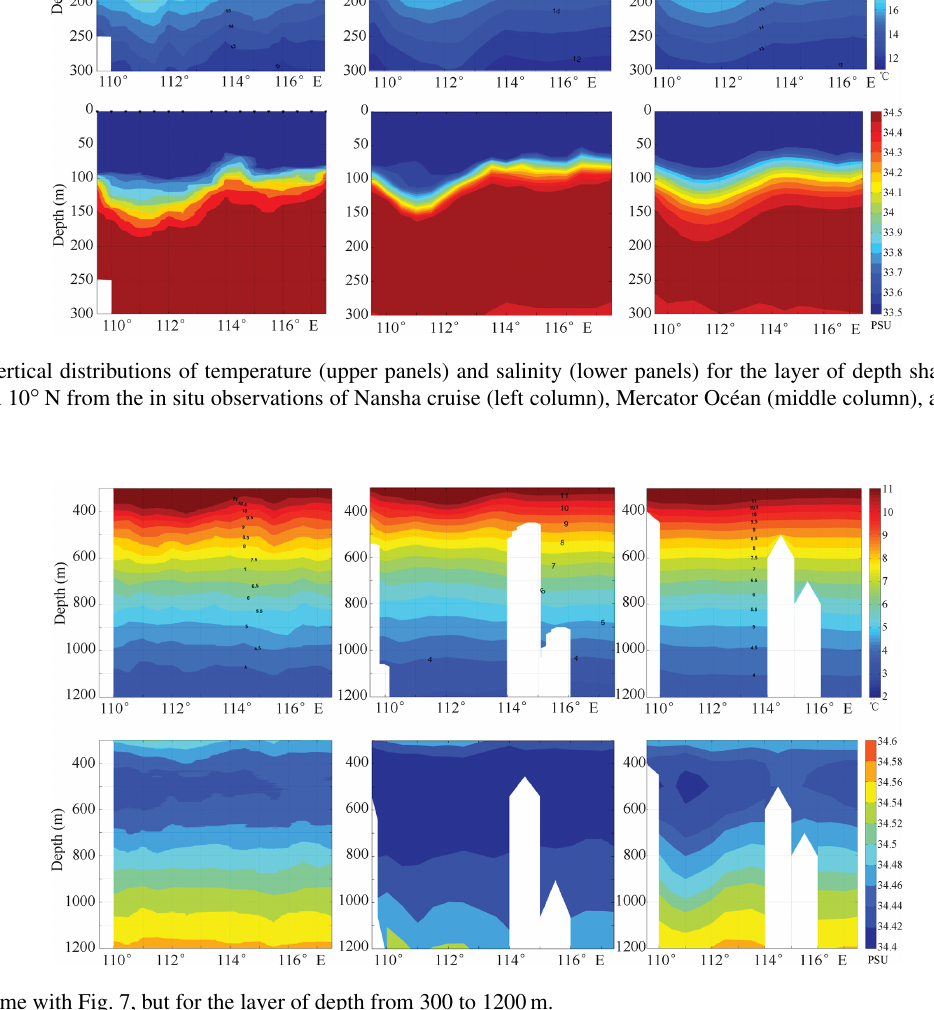
Figure 8. The same with Fig. 7, but for the layer of depth from 300 to